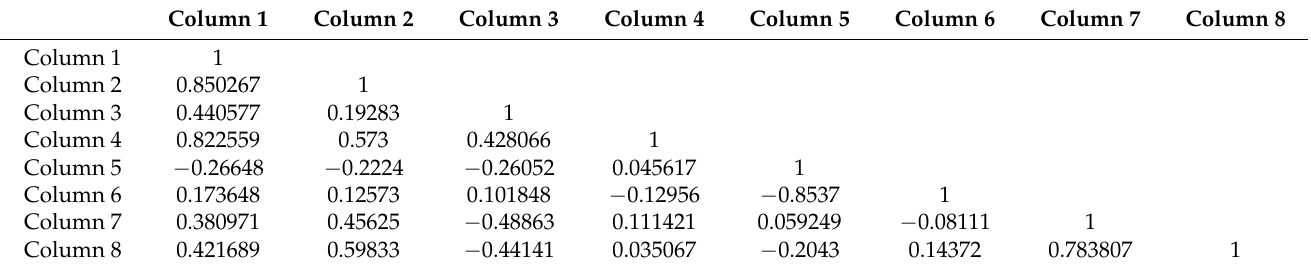
Table 16. Correlation matrix for model (9).